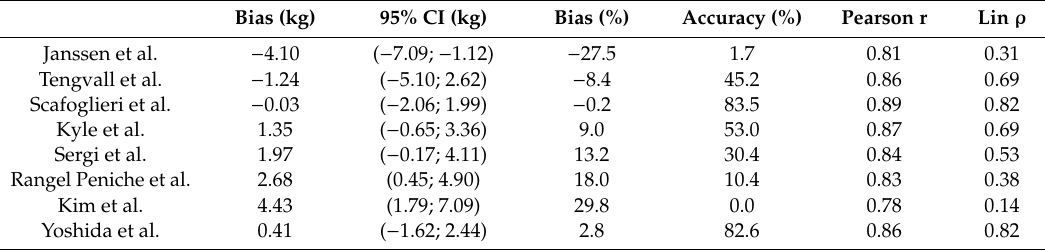
Table 6. Comparison of appendicular skeletal muscle mass values obtained by DXA and BIA according to the BIA equation used.